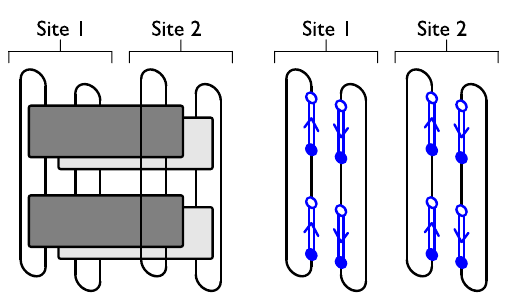
FIG. 6. The T and U loops (right) associated with a contracted diagram for Tr ½ W ð t ¼ 2 Þ(cid:2) Tr ½ W † ð t ¼ 2 Þ(cid:2) (left in this figure and top middle in Fig. 5). The associated algebraic factors are